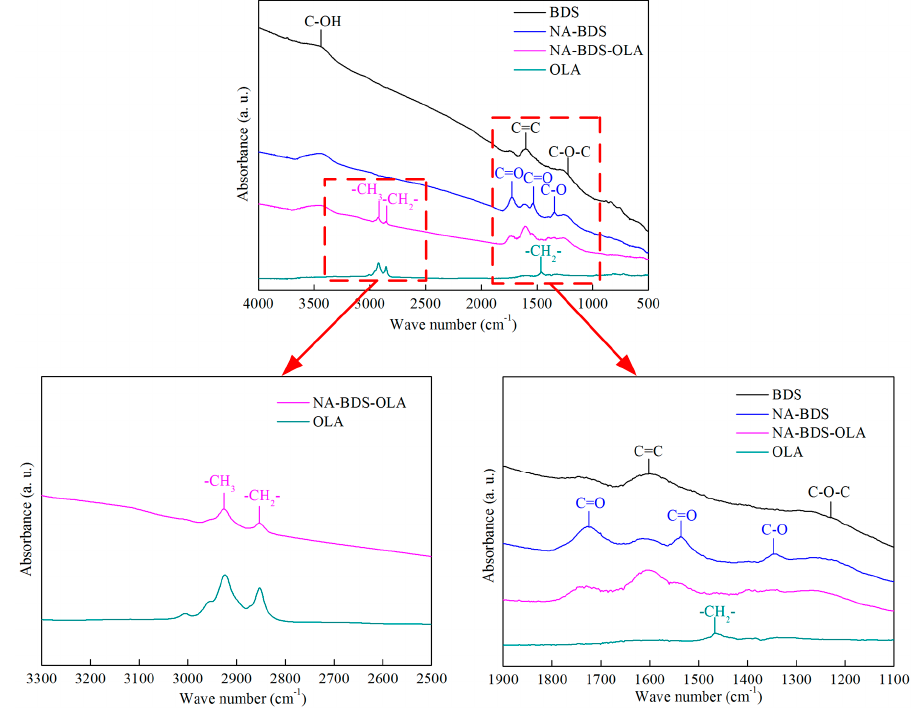
Figure 4. Fourier transform infrared (FTIR) spectra of oleylamine (OLA), BDS, NA-BDS, and NA-BDS-OLA.